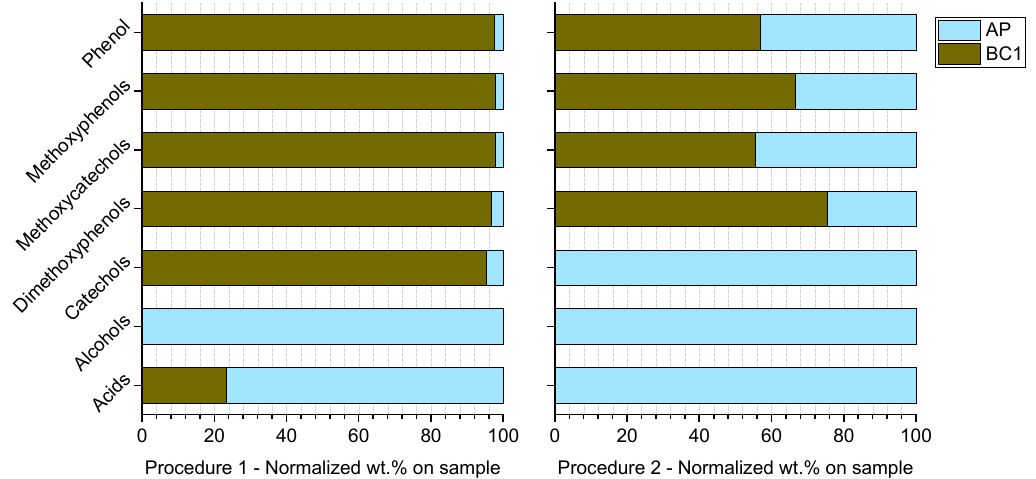
Figure 11. Influence of collection procedures on organic compounds distribution among BC1 and AP fractions. Tests performed at 350 °C, 10 min, 10 wt. % B/W in absence of catalysts.